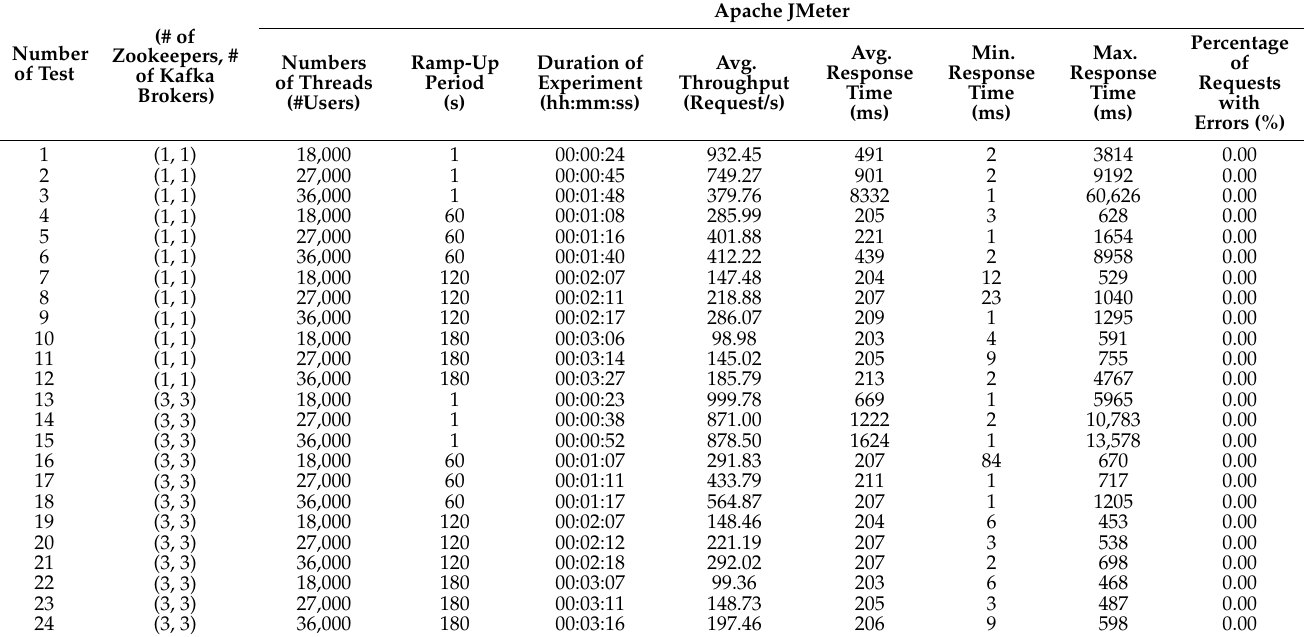
Table 5. Information on the experiments with the Kafka cluster using 1 and 3